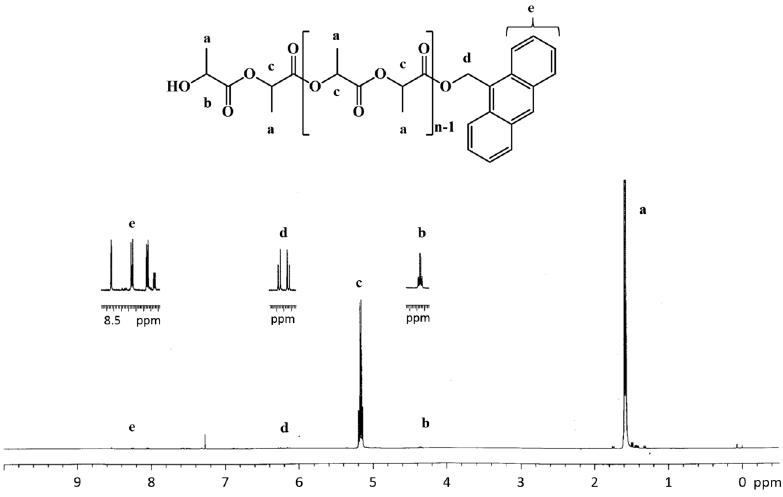
Figure 3. 1 H NMR spectrum of PLA-100 initiated by 4 in the presence of 9-AnOH in toluene at 0 °C.